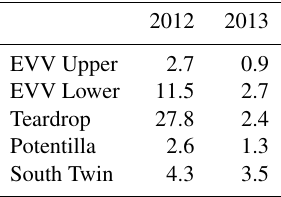
Table 3. Concentrations of CH4 (µM) in surface waters (0.5m) un- der open-water conditions in 2012 and 2013.